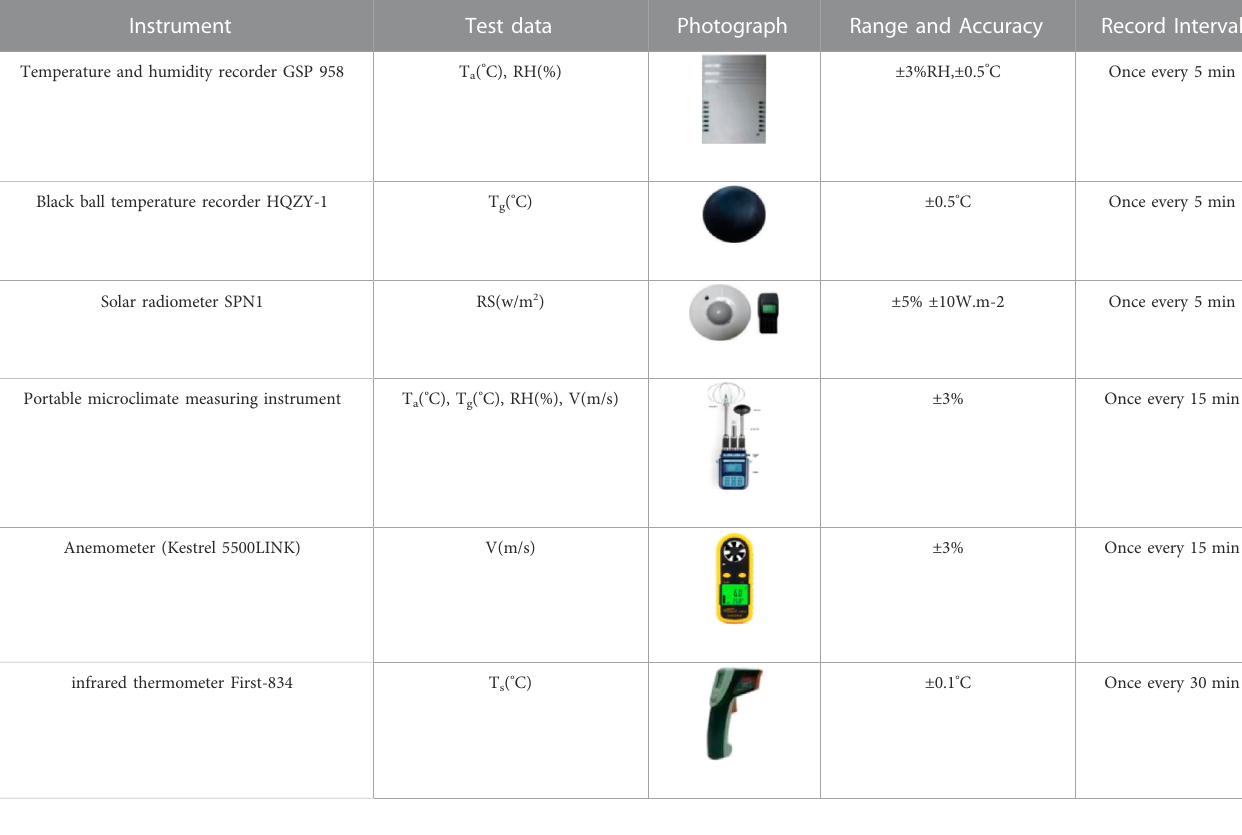
TABLE 2 Parameters of the measurement instruments.